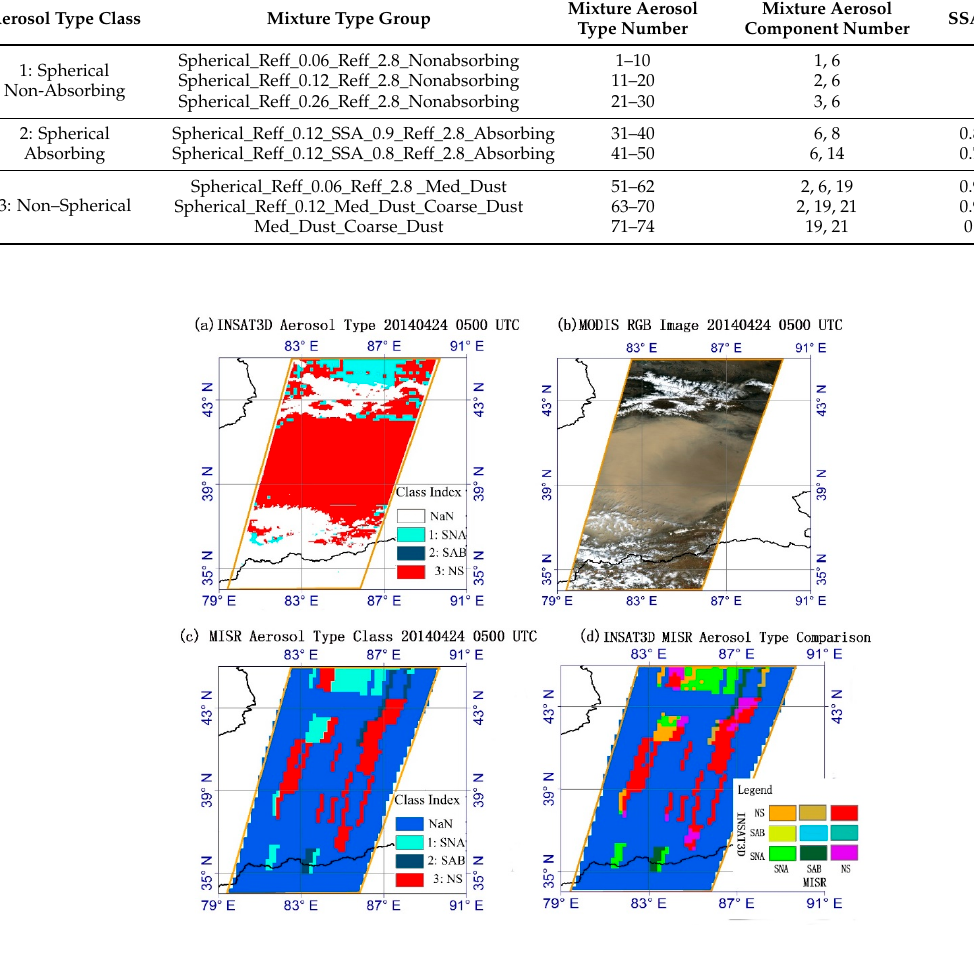
Figure 6. A comparison between INSAT 3D retrieved aerosol type and MISR Aerosol type: INSAT 3D retrieved aerosol types ( a ); MODIS RGB image ( b ) and MISR aerosol type product ( c ) at the